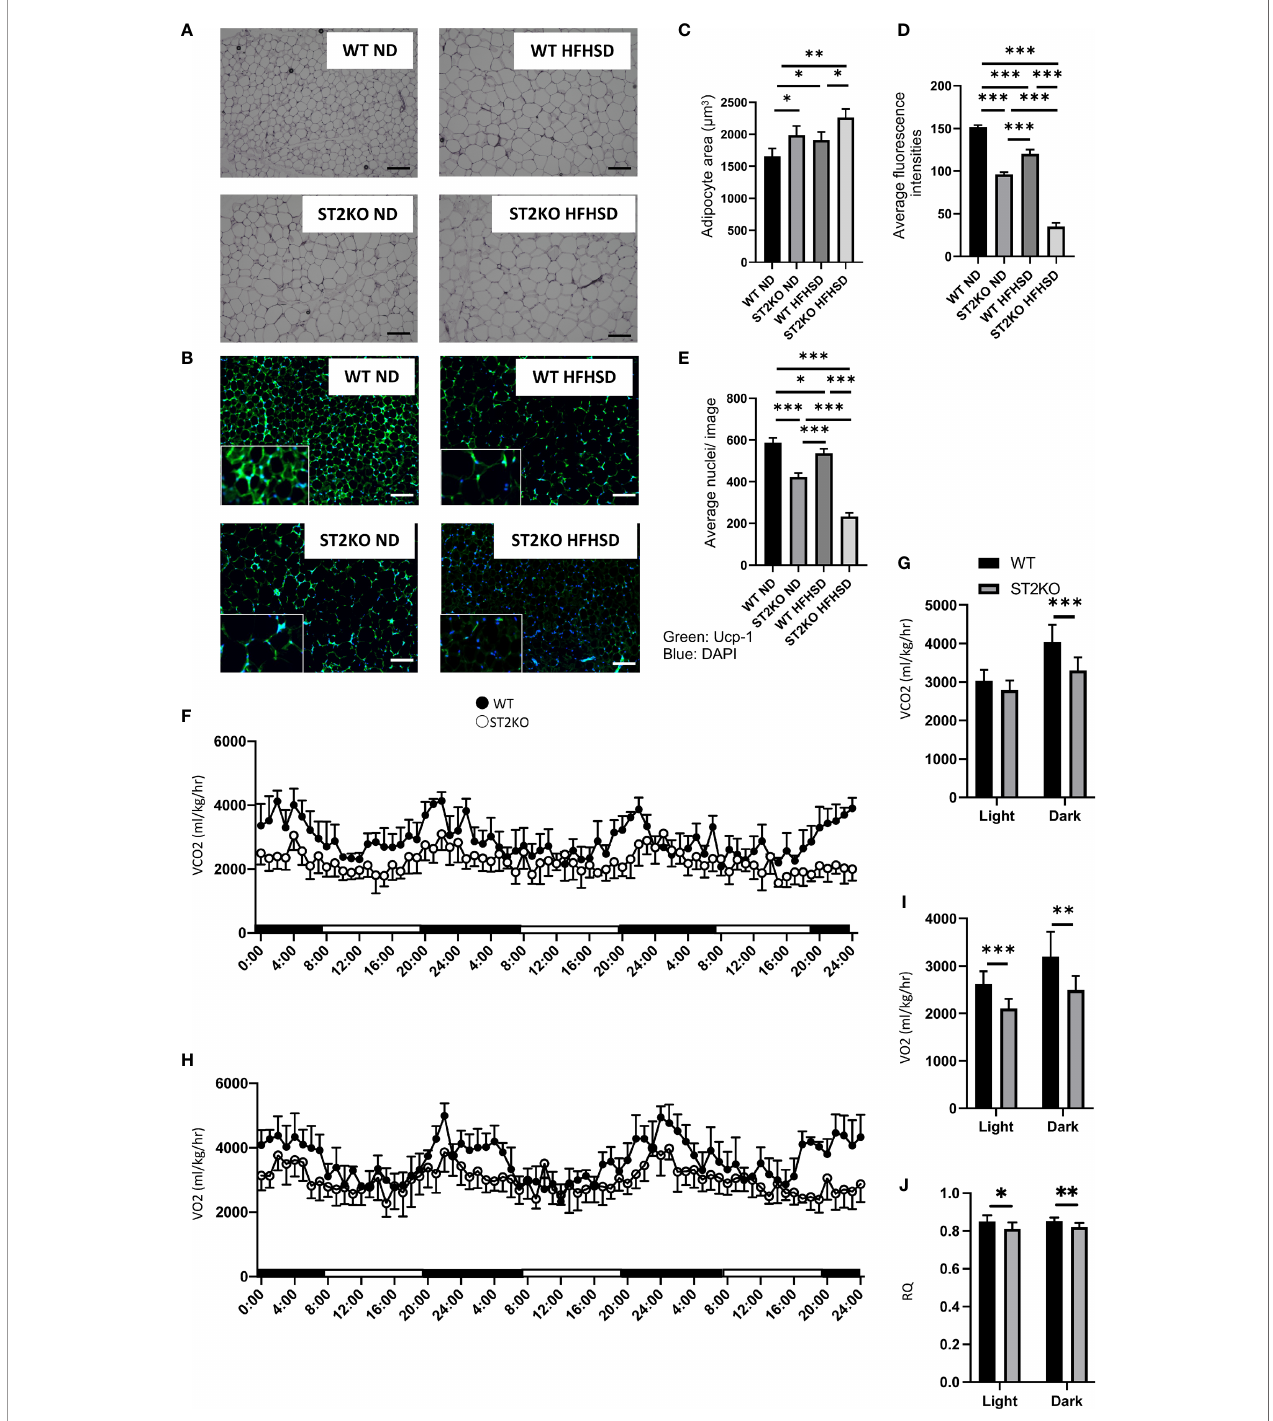
FIGURE 2 | ST2KO mice showed larger adipocytes and lower expression of Ucp-1 in eWAT and decreased the energy metabolism. (A) Hematoxylin and eosin- stained epididymal white adipose tissue sections (×400), scale bars, 50 m m. (B) The immune histochemistry of eWAT. Green: Ucp-1. Blue: DAPI. Scale bar, 50 µm. (C) Corresponding quantitation presented as the mean adipocyte area (n = 6). (D) The fl uorescence intensity of Ucp-1 (n = 6). (E) The number of cells in an image (n = 6). (F) Real-time monitoring curve of carbon dioxide release (VCO 2 ) (n = 6). (G) Quanti fi cation of carbon dioxide release (n = 6). (H) Real-time monitoring curve of oxygen consumption (VO 2 ) (n = 6). (I) Quanti fi cation of O 2 consumption (n = 6). (J) Quanti fi cation of RQ (n = 6). Data are represented as mean±SD; *p < 0.05, **p < 0.01, ***p < 0.001 by one-way